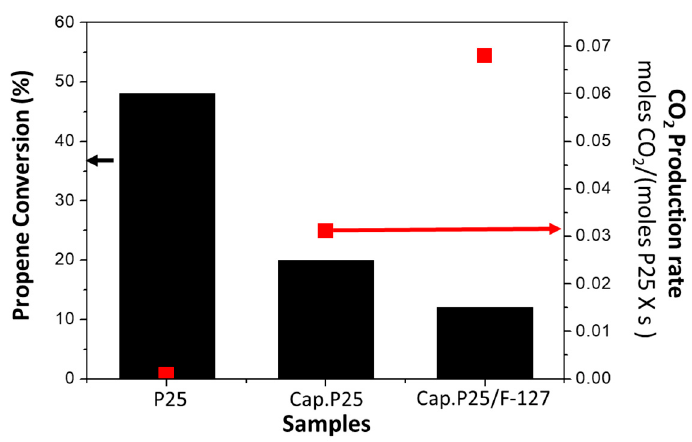
Figure 6. Comparison of propene conversion and CO 2 production rates for P25 incorporated in a conventional reactor (P25), P25 incorporated in a microcapillary (Cap. P25) and P25 with surfactant incorporated in a microcapillary (Cap. P25/F-127).